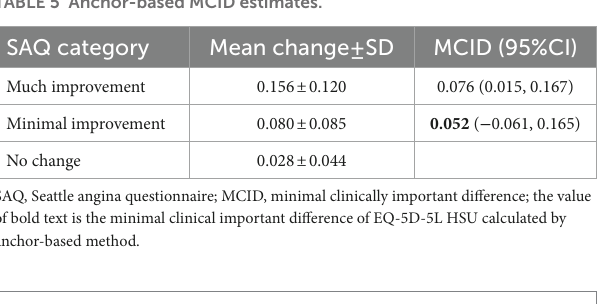
TABLE 5 Anchor-based MCID estimates.